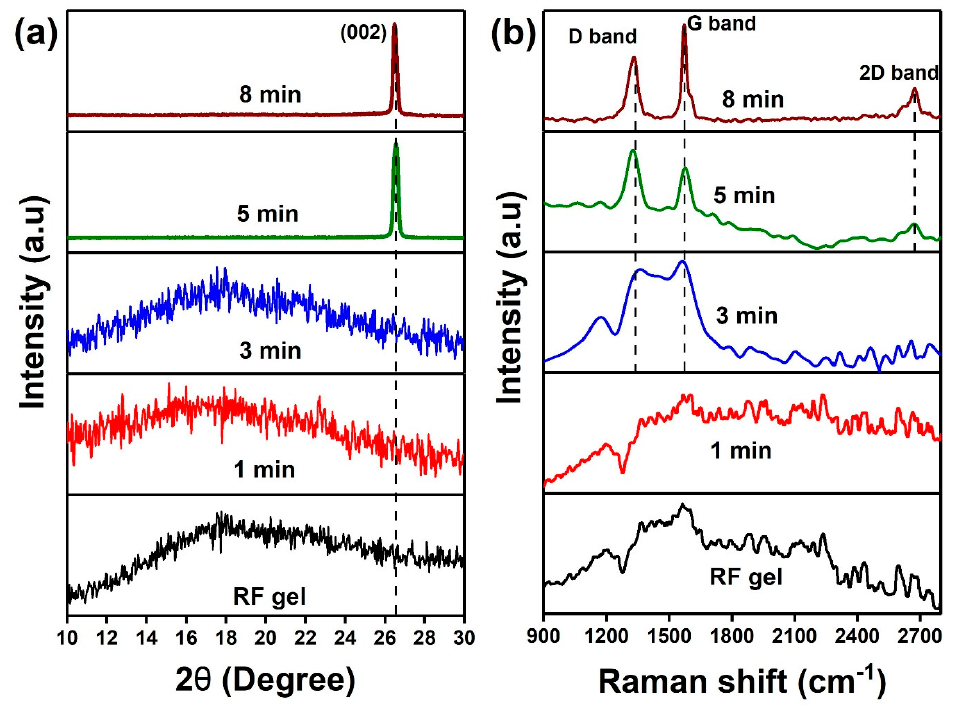
Figure 3. ( a ) XRD spectra and ( b ) Raman spectra of CNs obtained after the time-dependent plasma surface treatment on RF gel at 250 W and flow rate 100:50 sccm.